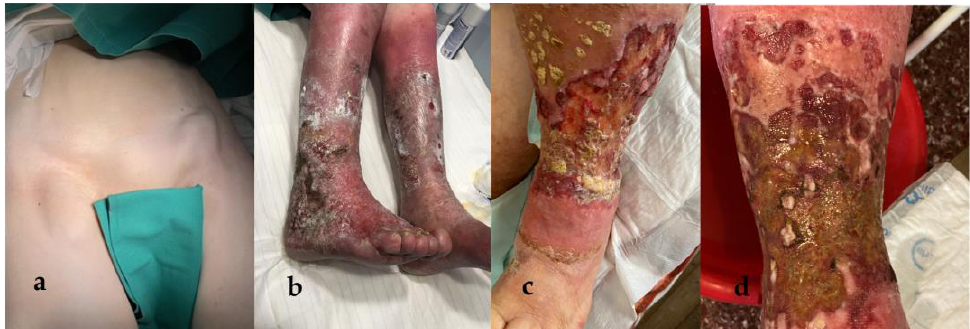
Figure 1. Preoperative images of the patient’s enlarged inguinal lymph nodes ( a ) and the chronic lesion of the lower extremities; image from an extensive archive, similar to that of the lesion at the time of presentation ( b ). The lesions’ clinical course was complicated by ulcerations, with active infection and crusting ( c , d